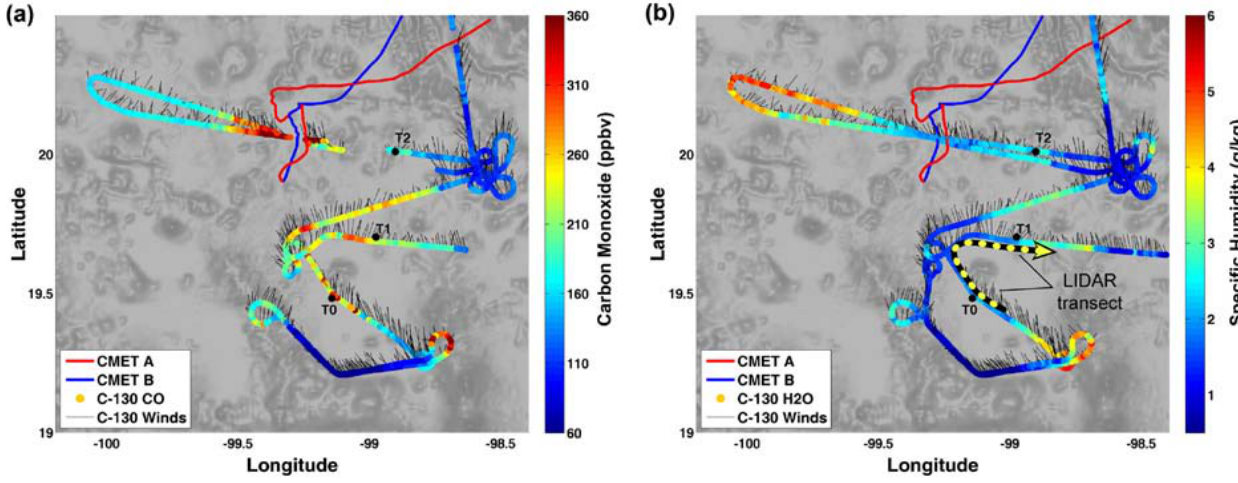
Fig. 7. (a) Carbon monoxide as measured by the C-130 during the afternoon of 18 March at altitudes ranging from 0–2kma.g.l. The polluted air near T1, sampled at about 23:00 UTC, moved steadily north and was likely closely associated with the CMET balloons as they left the basin at approximately 00:00 UTC (see text). The barbs along the C-130 flight track show the observed winds converted to transport distance over a 15min period. (b) Specific humidity was generally anticorrelated with pollution levels in the northwest quadrant of the city (i.e., dry air had elevated CO). This relationship allowed the balloon’s humidity measurements to be used as a rough proxy for pollution levels, especially during the first several hours of flight. The dashed yellow line shows the approximate location of the LIDAR image in Fig.